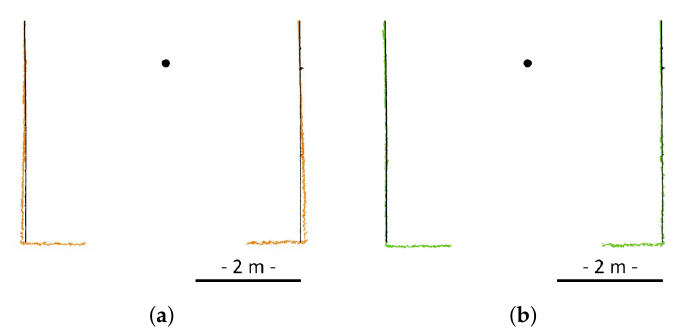
Figure 10. Vertical cross section of the MSS (in color) and TLS (in black) point clouds: (a) before and (b) after tilt angle